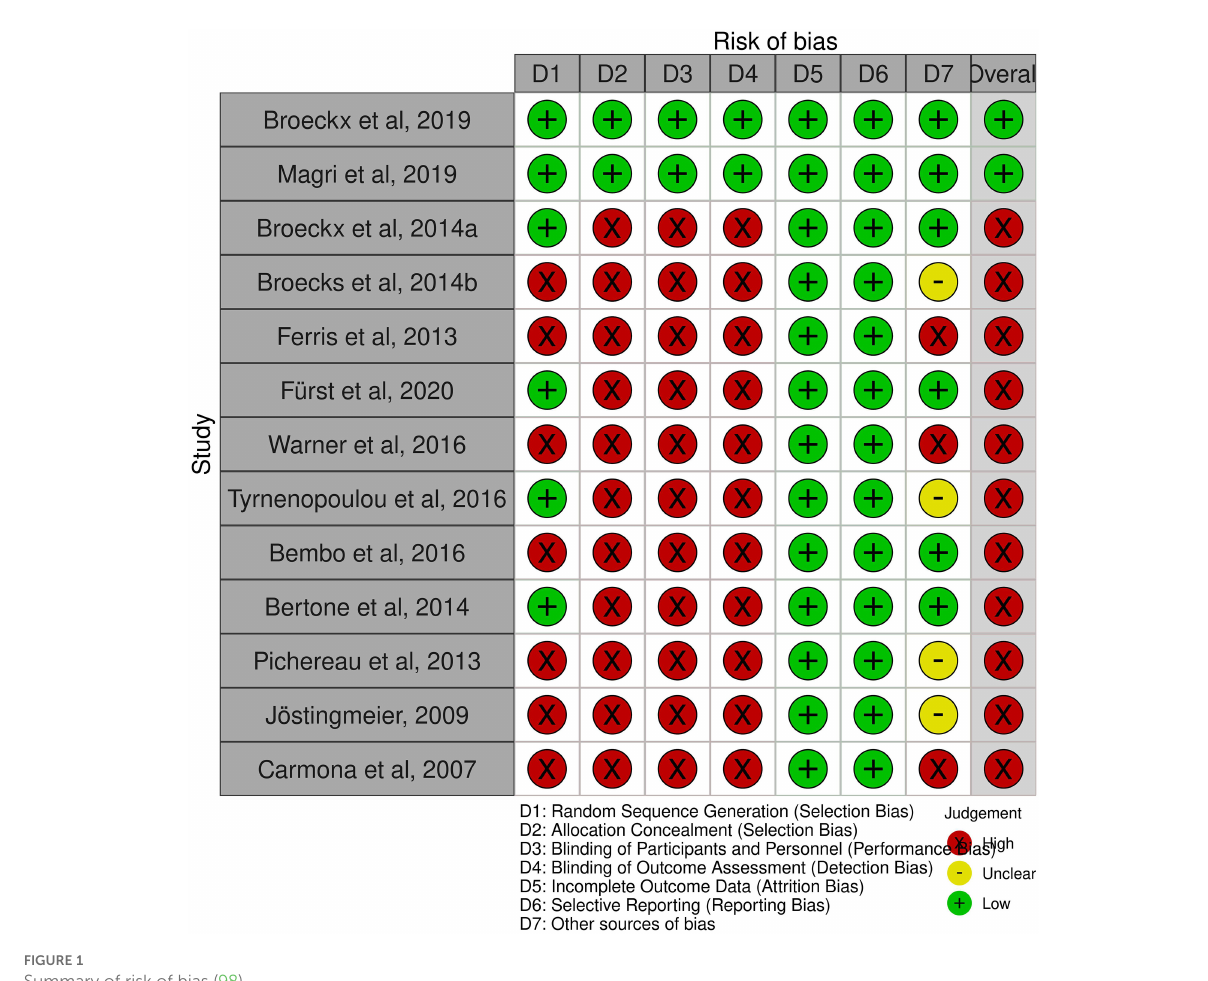
FIGURE1 Summary of risk of bias (98).